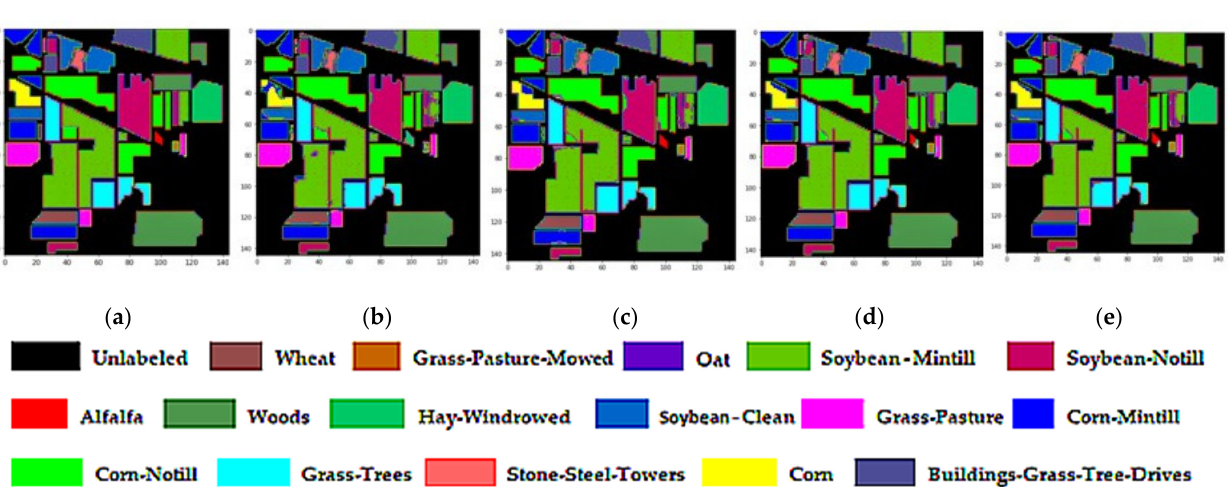
Figure 16. Classification maps of IP dataset: ( a ) Ground truth; ( b ) R-HybridSN; ( c ) HybridSN; ( d ) SSRN ( e ) HybridGBN-SR.